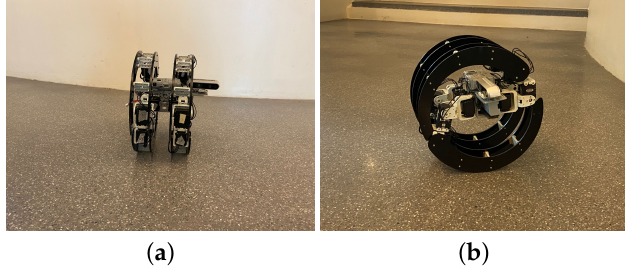
Figure 10. Rolling locomotion mode. ( a ) Front view. ( b ) Side view.